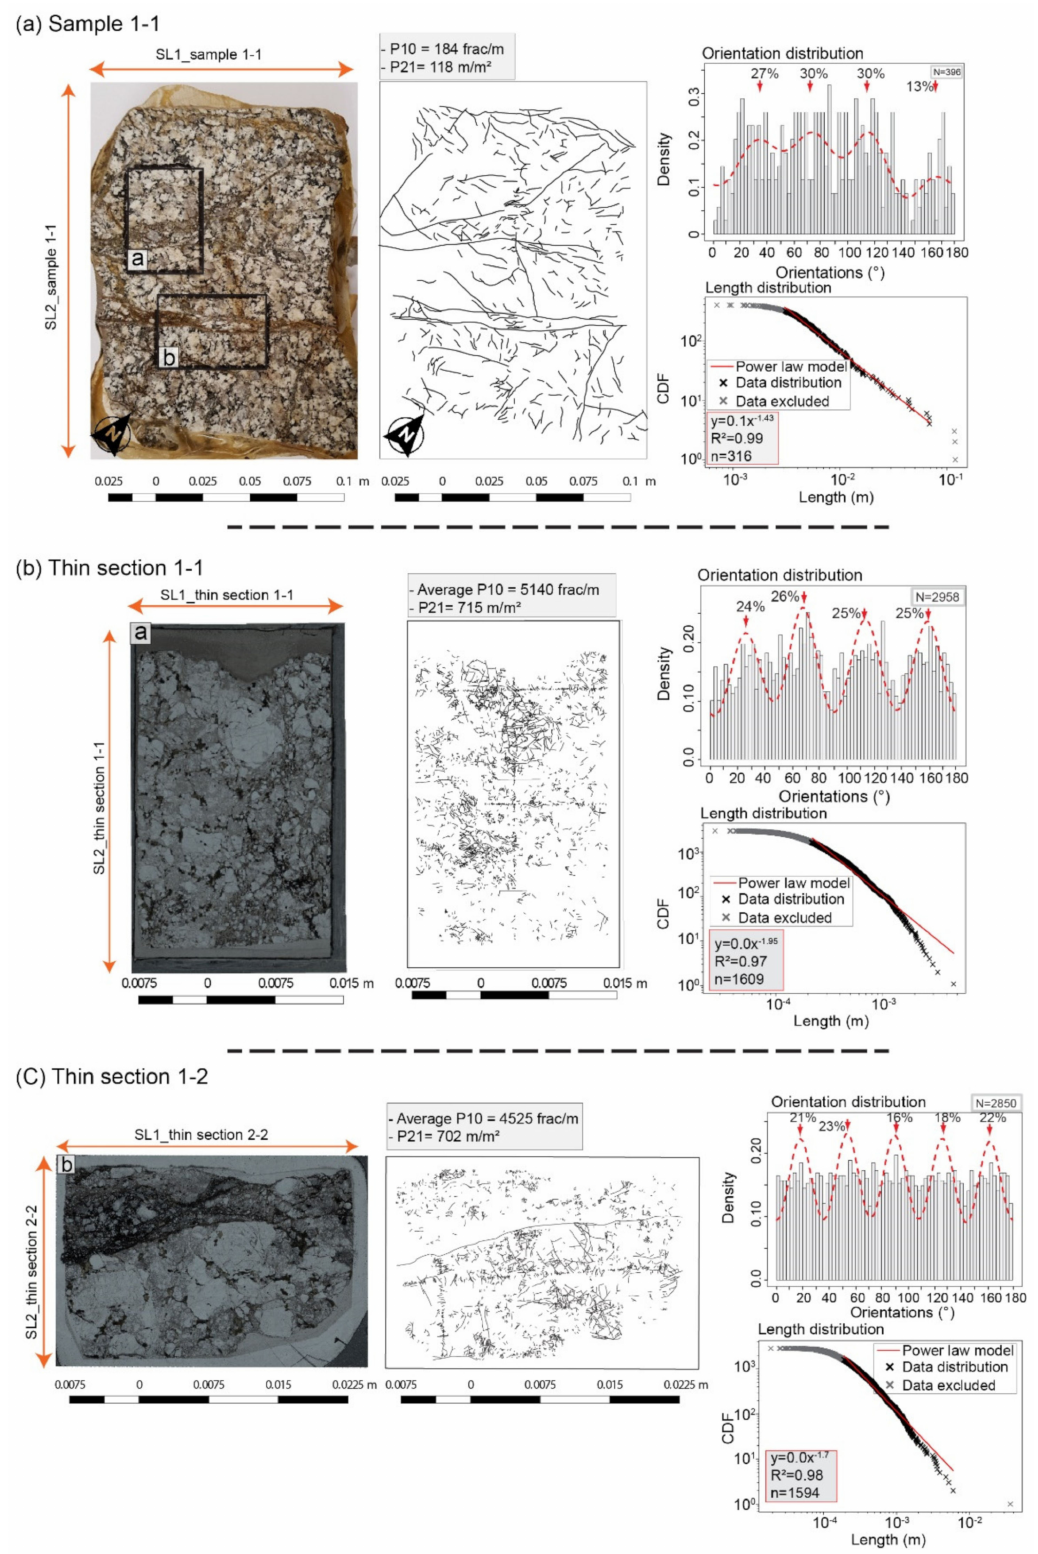
Figure 7. Fracture traces, orientation and length distributions from ( a ) sample 1-1, ( b ) thin section 1-1, and ( c ) thin section 1-2 sampled from fracture map 1. Different datasets are expressed into histograms for orientations distribution, and into cumulative distribution function (CDF) of lengths. Two scanlines (SL) were taken for each map. For orientation distribution legend, see Figure